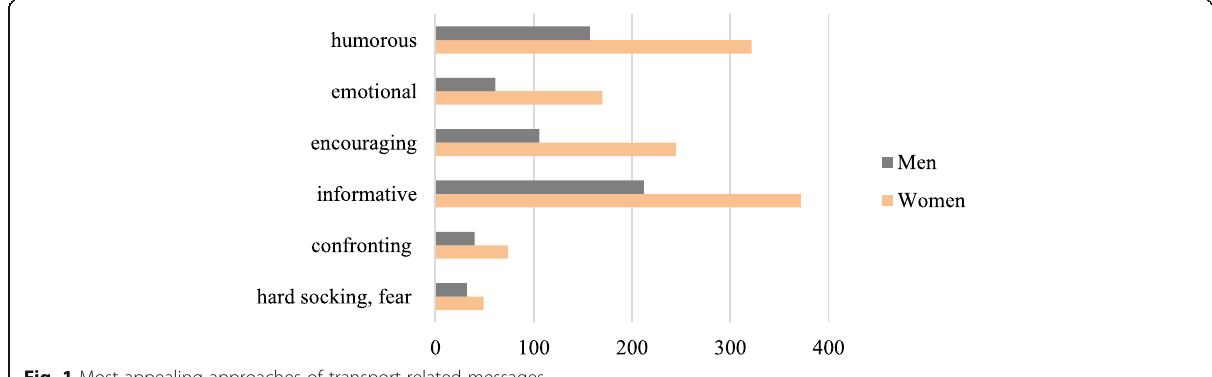
Fig. 1 Most appealing approaches of transport related